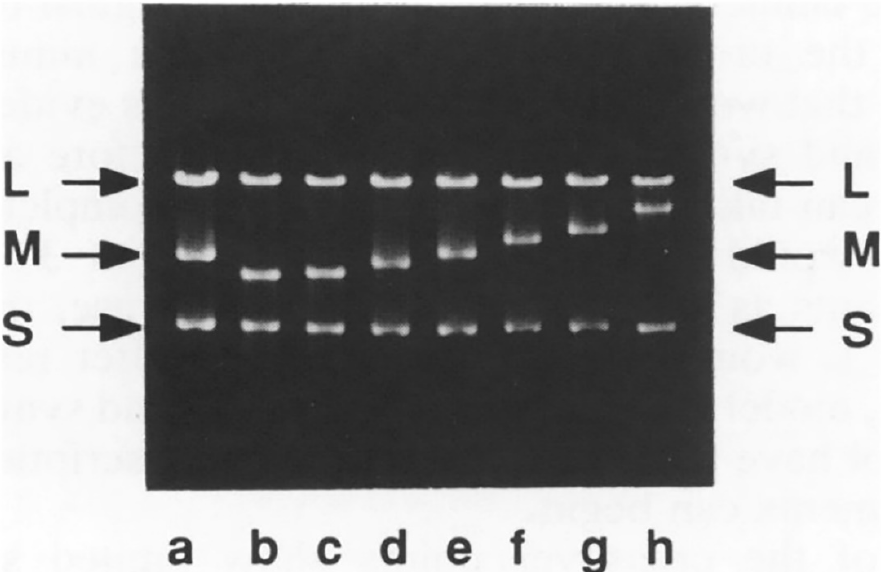
Figure 4. The recombination facilitated by homopolymer base hairpin conformations resulted in an alteration in size of the M dsRNA segment. The agarose electrophoresis gel of dsRNA extracted from recombinant plaques shows a whole variety of sizes of recombinant M segment. Line a shows the dsRNA extracted from φ 6. Lines b–h are from recombinant plaques. Upper case denotes dsRNA segments. Reproduced from Onodera et al. (1993).